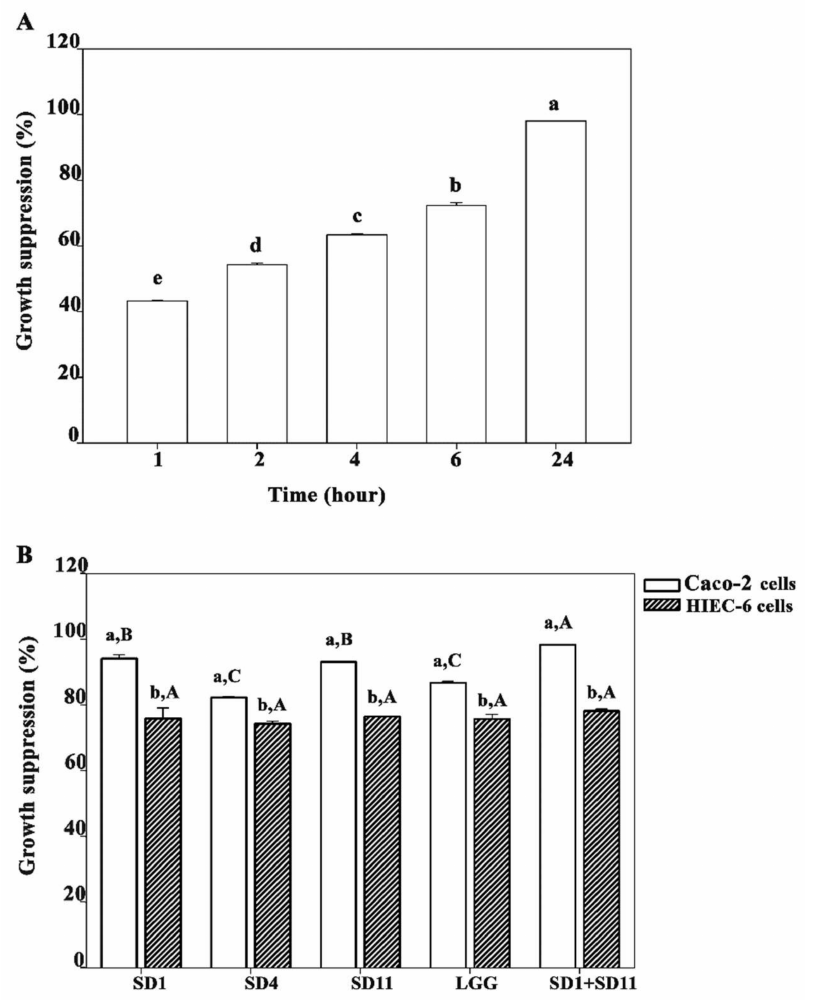
Figure 4. The growth-suppression percentage for 8 mM butyrate produced from probiotics: ( A ) time- dependent growth suppression of Caco-2 cells and ( B ) growth suppression of Caco-2 and HIEC-6 cells by individual probiotic strains and a combination of L. paracasei SD1 and L. rhamnosus SD11 at 24 h. Lowercase letters indicate ( A ) statistical difference in growth suppression by short-chain fatty acids (SCFAs) at various times or ( B ) statistical difference in growth suppression of Caco-2 or HIEC-6 cells by individual probiotic strains ( p < 0.05). Uppercase letters indicate statistical difference in growth suppression of either Caco-2 cells or HIEC-6 cells treated with SCFAs produced from each probiotic strain and a combination of L. paracasei SD1 and L. rhamnosus SD11 ( p < 0.05). The